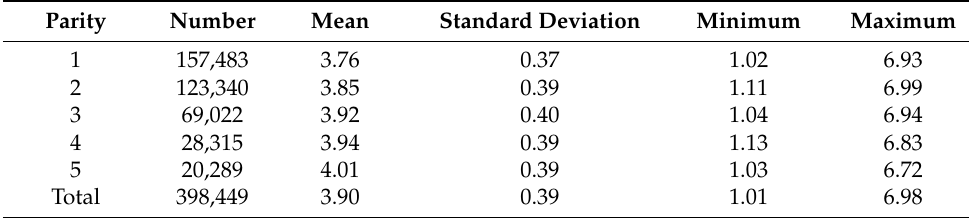
Table 2. Basic information of milk fat percentage data for dairy cows at each parity.